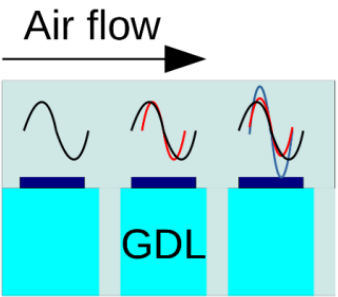
due to the air flow ℎ1 𝑐𝑐